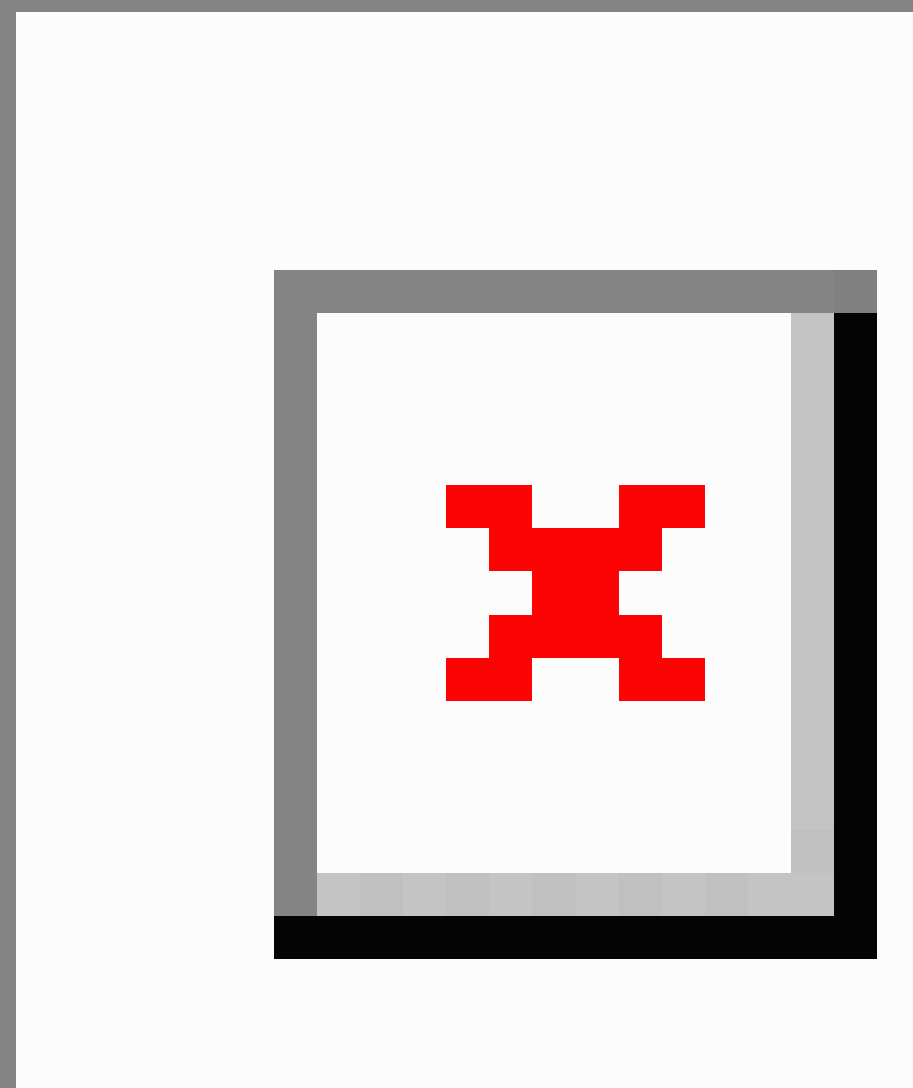
Figure 2. Effect of digital decision support